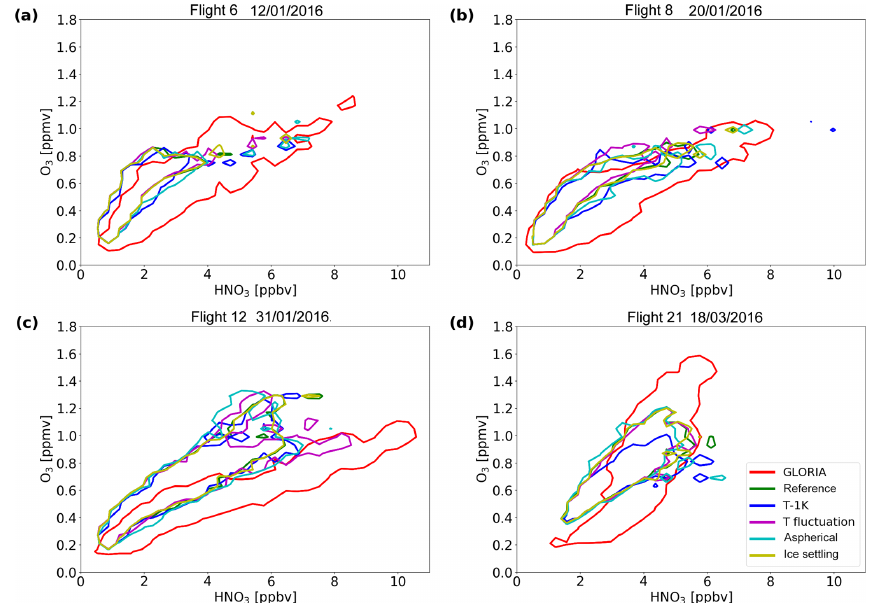
Figure 6. Isolines (contours at 0.02) of the normalized frequency distribution of the O 3 –HNO 3 correlation for (a) flight 6 on 12 January 2016, (b) flight 8 on 20 January 2016, (c) flight 12 on 31 January 2016, (d) flight 21 on 18 March 2016 derived from GLORIA measurements (red) and CLaMS simulations. The reference in the panels corresponds to model reference run without